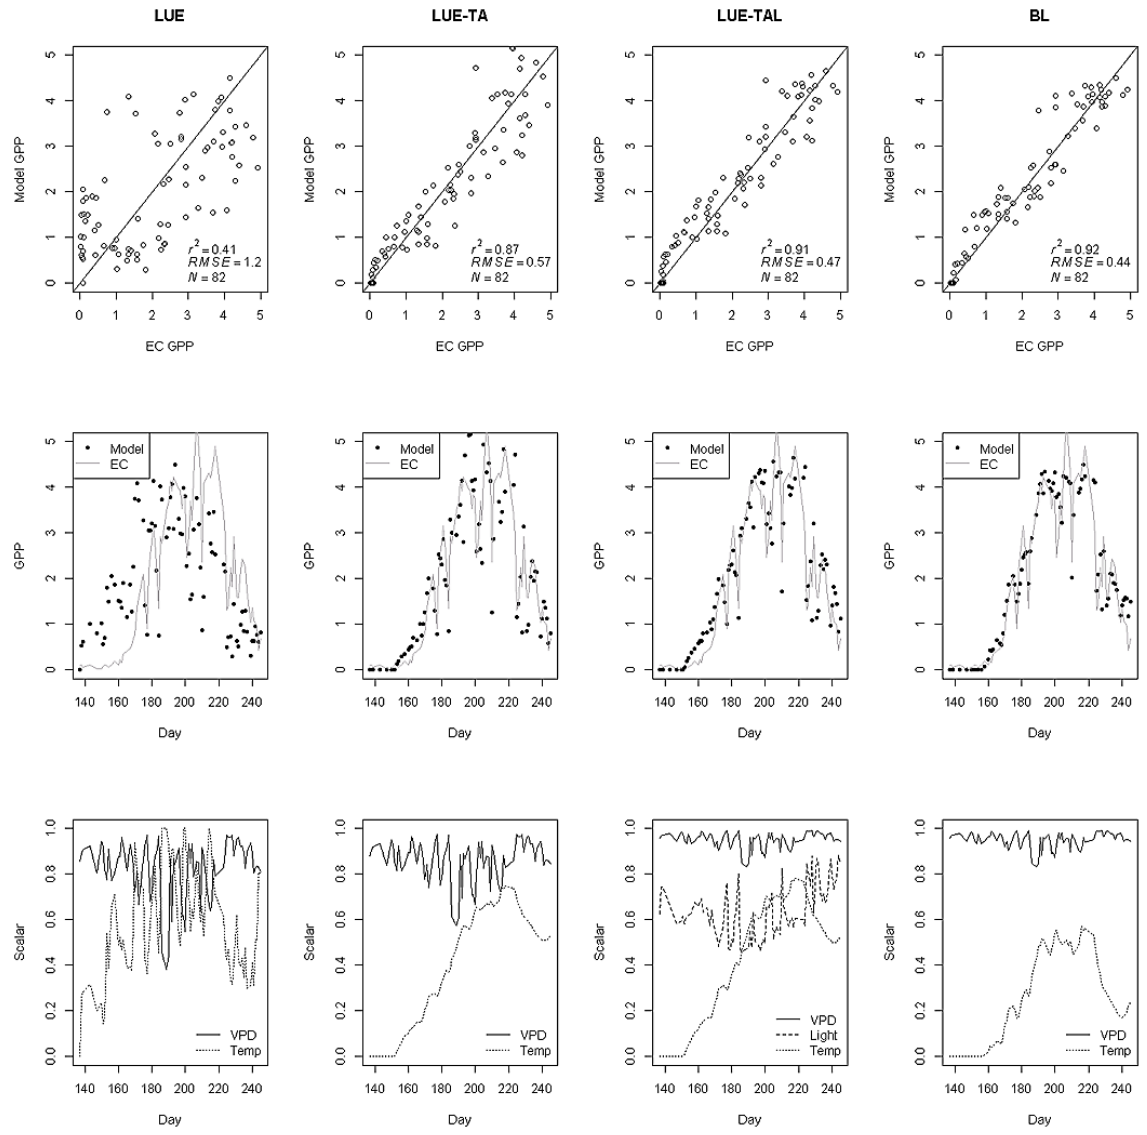
Fig. 2. Results for Cherskii, 2003, from the LUE (1st column), LUE-TA (2nd column), LUE-TAL (3rd column) and BL (4th column) models where the top row depicts scatterplots of eddy covariance (EC) GPP vs. model GPP, the middle row depicts the daily course of GPP (EC and model) and the bottom row depicts the environmental scalars for temperature and VPD. GPP in units of gCm − 2 d − 1